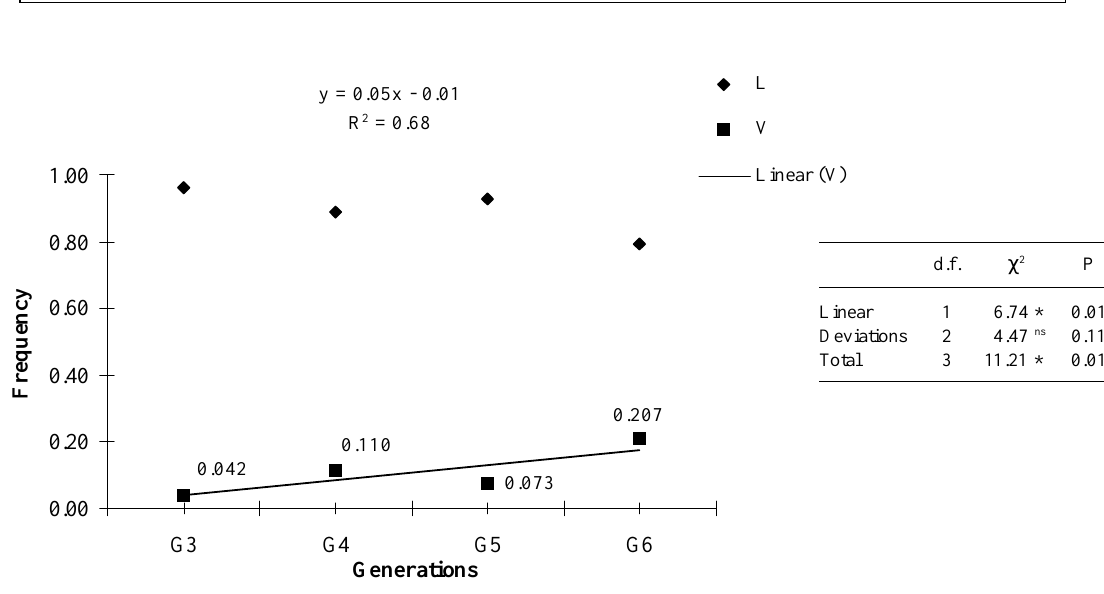
Figure 1 - Frequency variation of growth hormone alleles L and V over different generations of Canchim cattle. Results of chi- square analysis are shown on the top right of the figure. ns and *: Nonsignificant and significant at P < 0.05,